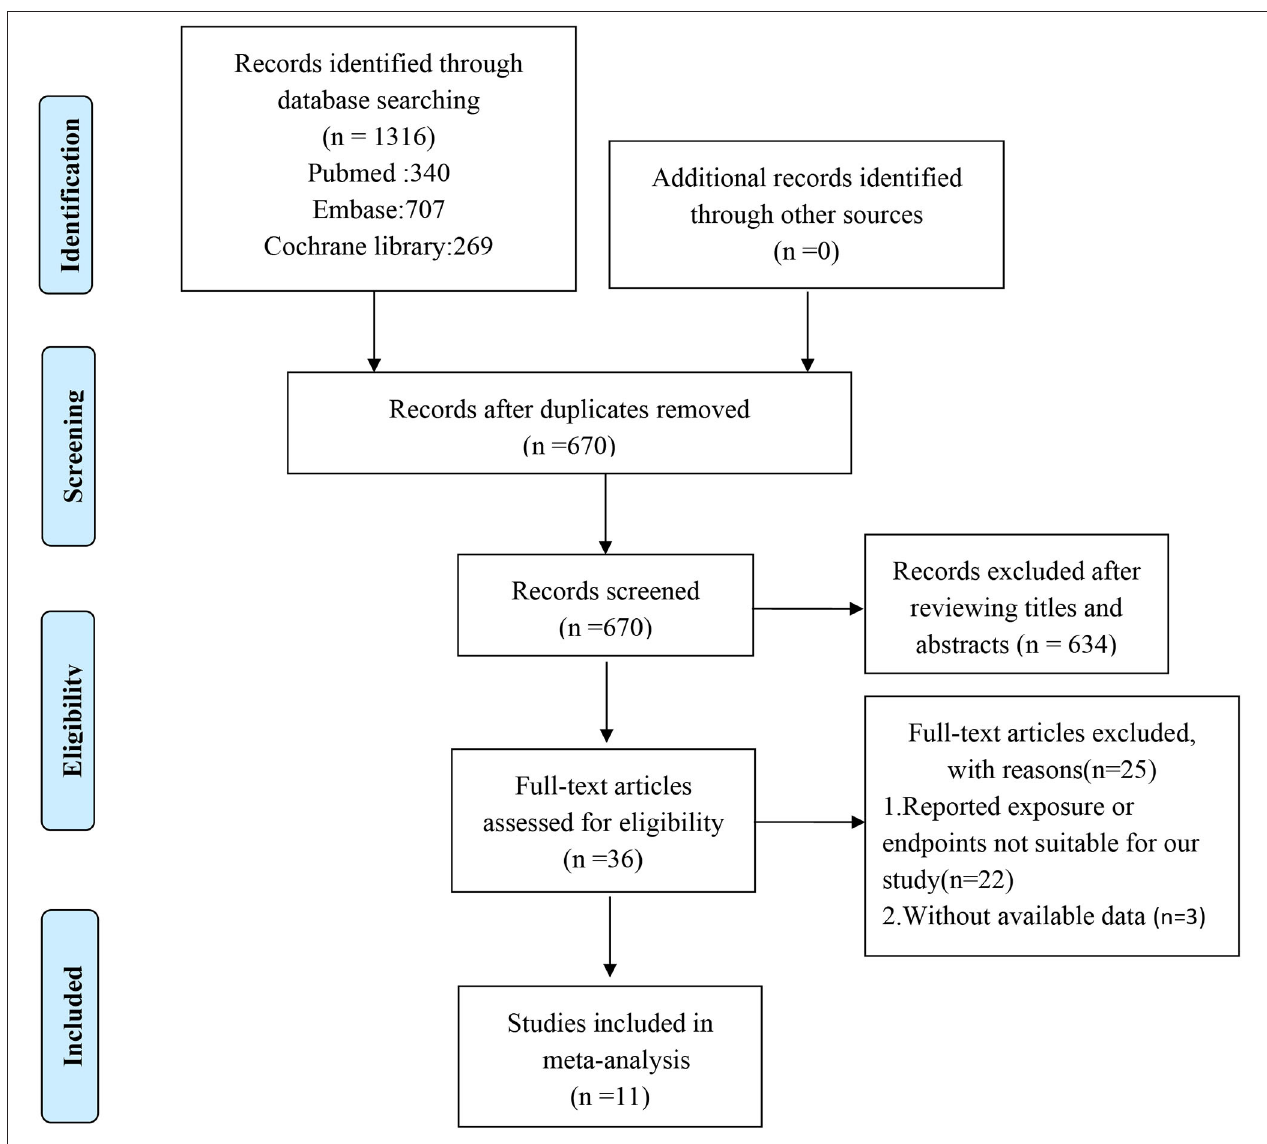
FIGURE 1 | The flow chart of study